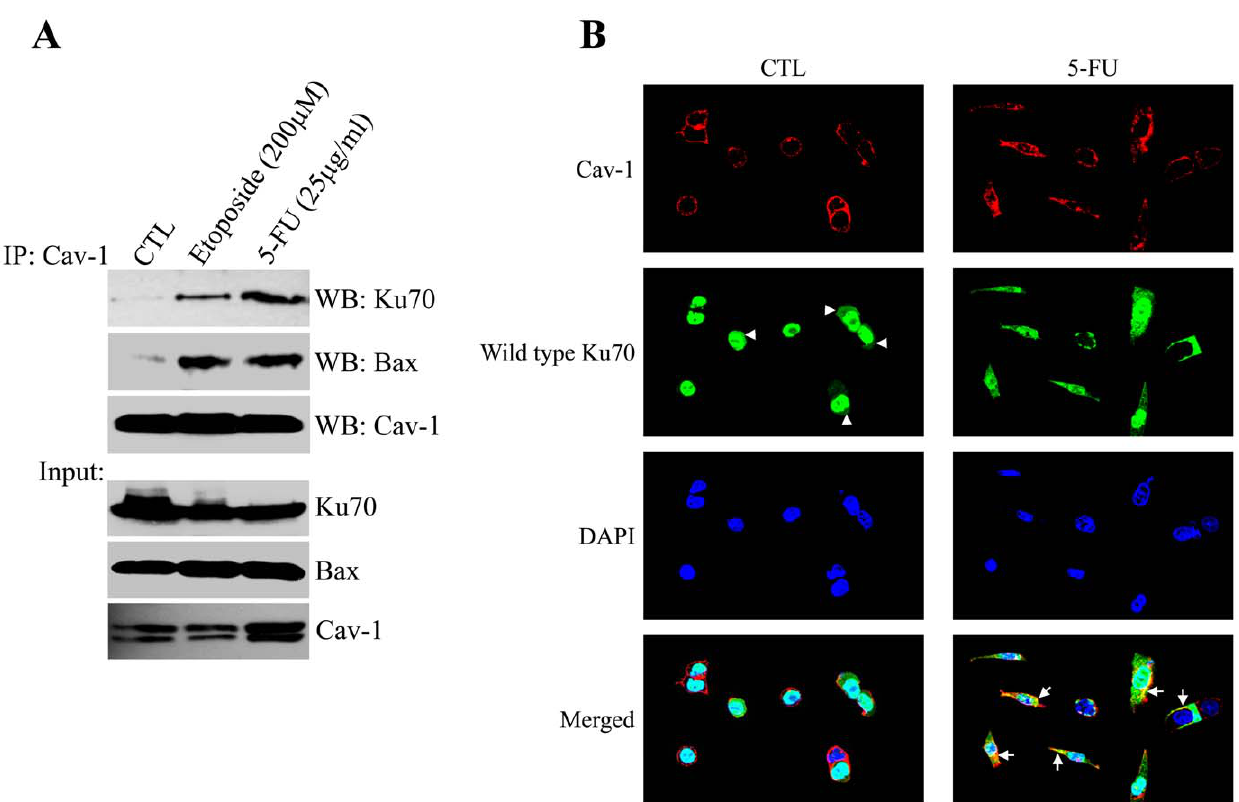
Figure 4. Chemotherapeutic drugs promote the Ku70-Cav-1 interaction. ( A ) HCT116 cells were treated with either etoposide or 5-FU for 24 hours. Untreated cells were used as control. Cell lysates were then immunoprecipitated with an antibody probe specific for caveolin-1 and immunoprecipitates subjected to immunoblotting analysis with anti-Ku70, anti-Bax and anti-caveolin-1 IgGs. ( B ) HCT116 colon cancer cells were transfected with HA-tagged wild type Ku70. One day after transfection, cells were treated with 5-FU for 24 hours. Untreated cells were used as control. Cells were then subjected to immunofluorescence analysis using antibody probes specific for the HA tag (green) and caveolin-1 (red). Nuclei were detected by DAPI staining (Blue). Yellow staining in the merged images shows co-localization between caveolin-1 and Ku70 only after 5-FU treatment (see arrows). Representative images are shown.